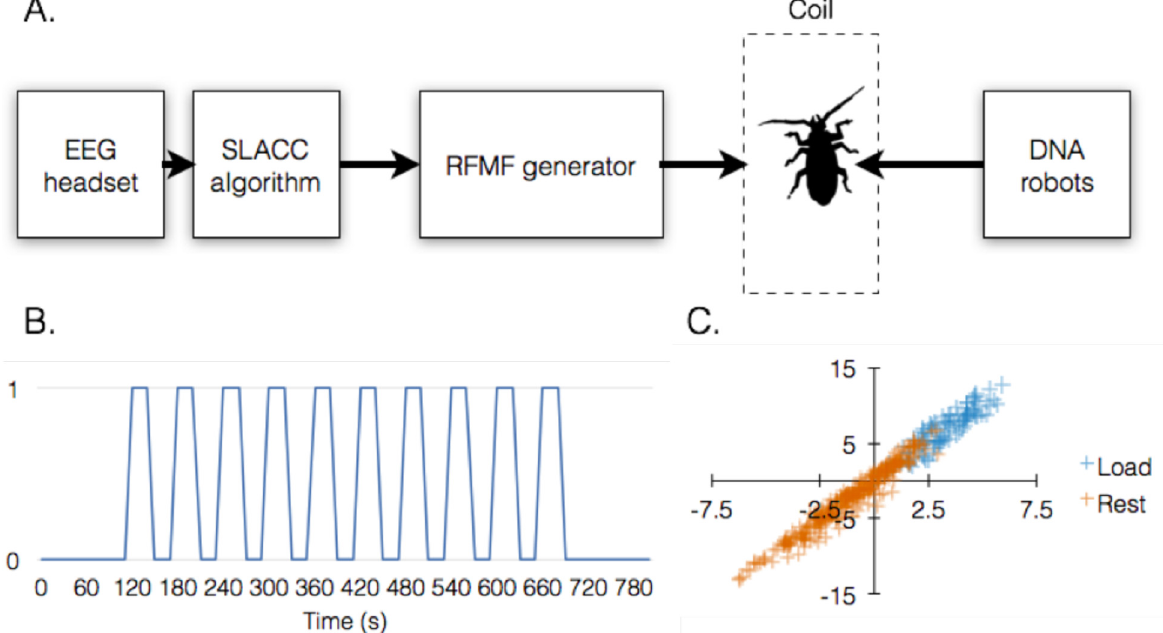
Fig 1. System outline and performance. (A) Basic system outline: signals recorded by the EEG headset on the subject were monitored by the SLACC algorithm, which controls the state of an RFMF generator connected to an induction coil. The test animal is placed inside the coil after being injected with DNA robots. (B) Experimental protocol structure. 0 and 1 on the Y-axis denote states of cognitive rest and load, respectively, which are induced by displaying alternating screens showing either nothing or a list of arithmetic problems (S1 File) , respectively. (C) Classification of cognitive rest vs. cognitive load signals by